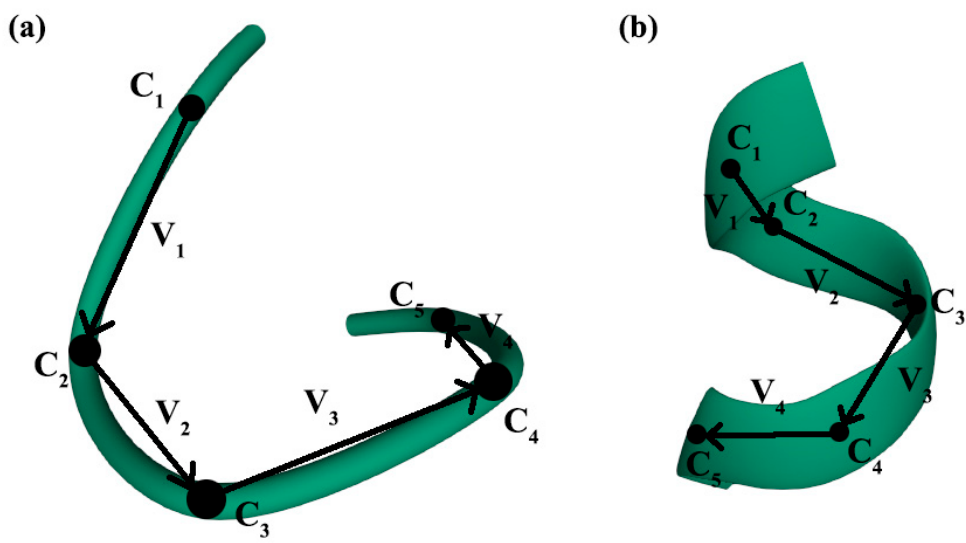
Figure 3. Graphic construction of v i vectors for calculating the mixed vector product, α -turns of the 2FOX protein [97]: ( a ) α -turn, type g4 [98]; ( b ) α -turn, type g5 [98] (the studied types of α -turns are discussed in the Results section). C i –atoms of α -carbons, reference points in α -turns.